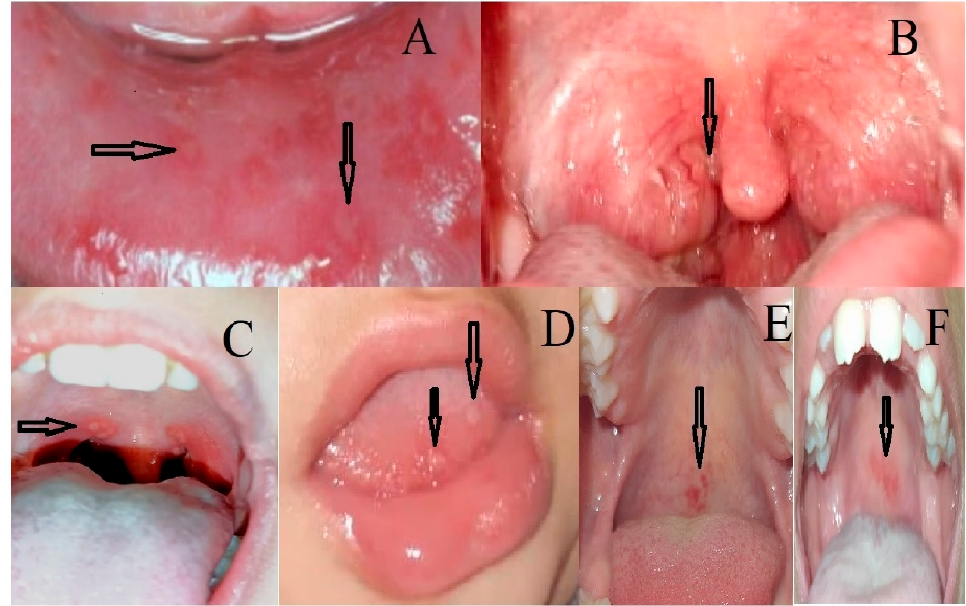
Figure 1. ( A , B ) the classical aphthous stomatitis and pharyngitis in PFAPA. ( C – F ) the range of oral lesions presented in our patients. ( C ) Ulcerative lesions in the soft palate and posterior oropharynx. ( D ) Blisters in the tongue tip. ( E , F ) Erythematous palate. ( D ) Blisters in the tongue tip. ( E , F ) Erythematous